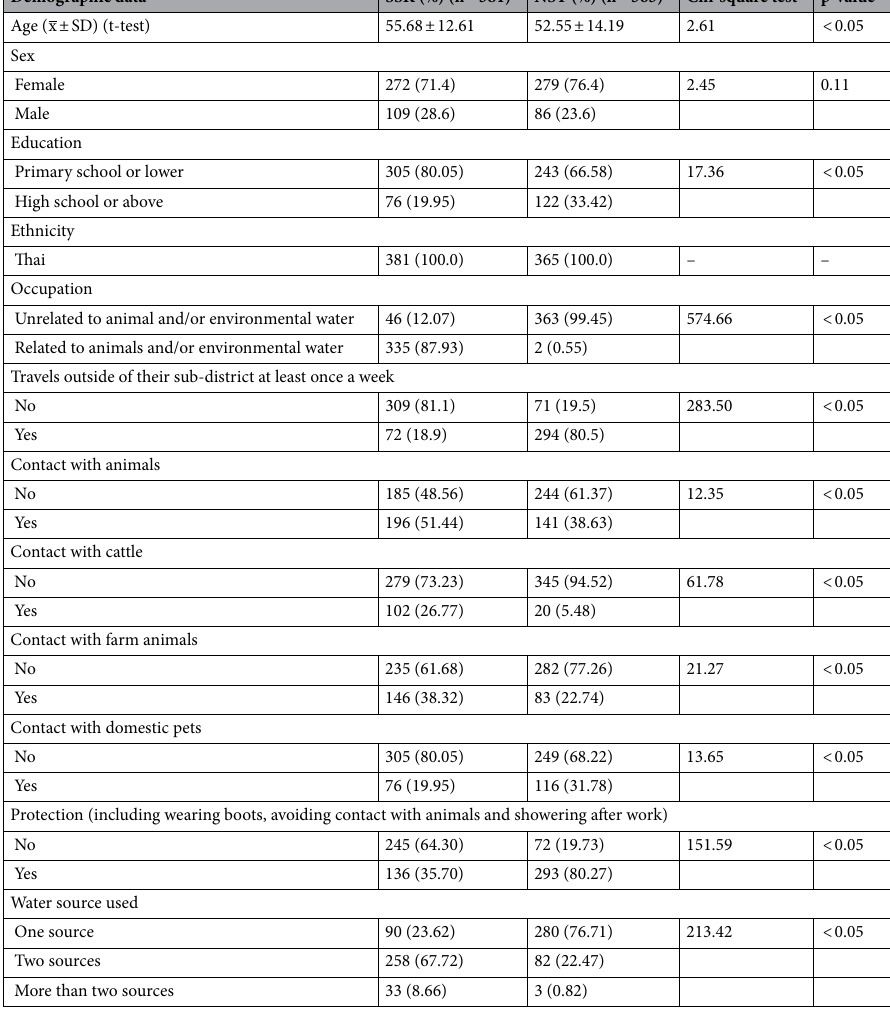
Table 1. Demographics and characteristics of study